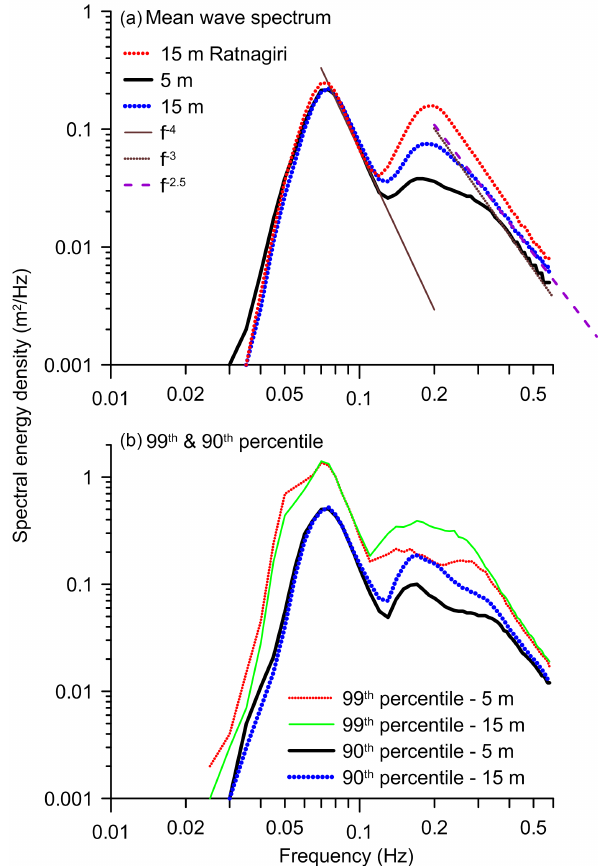
Figure 11. (a) Mean and (b) 90 and 99 percentiles of one- dimensional wave energy spectra for the entire study period. Fre- quency tails are f − 4 (solid), f − 3 (dotted) and f − 2 . 5